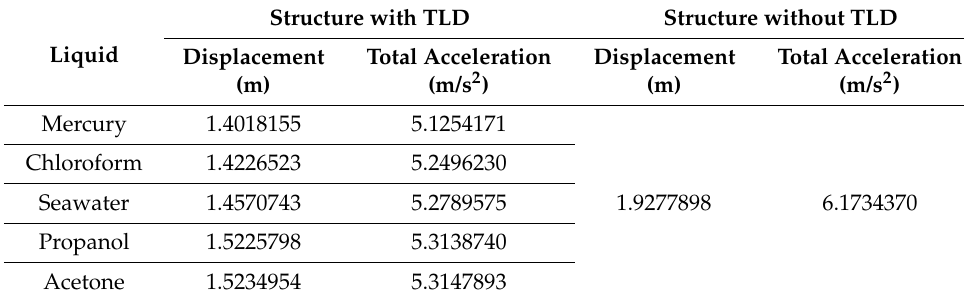
Table 10. TLD + 40-story building model critical seismic analysis results.